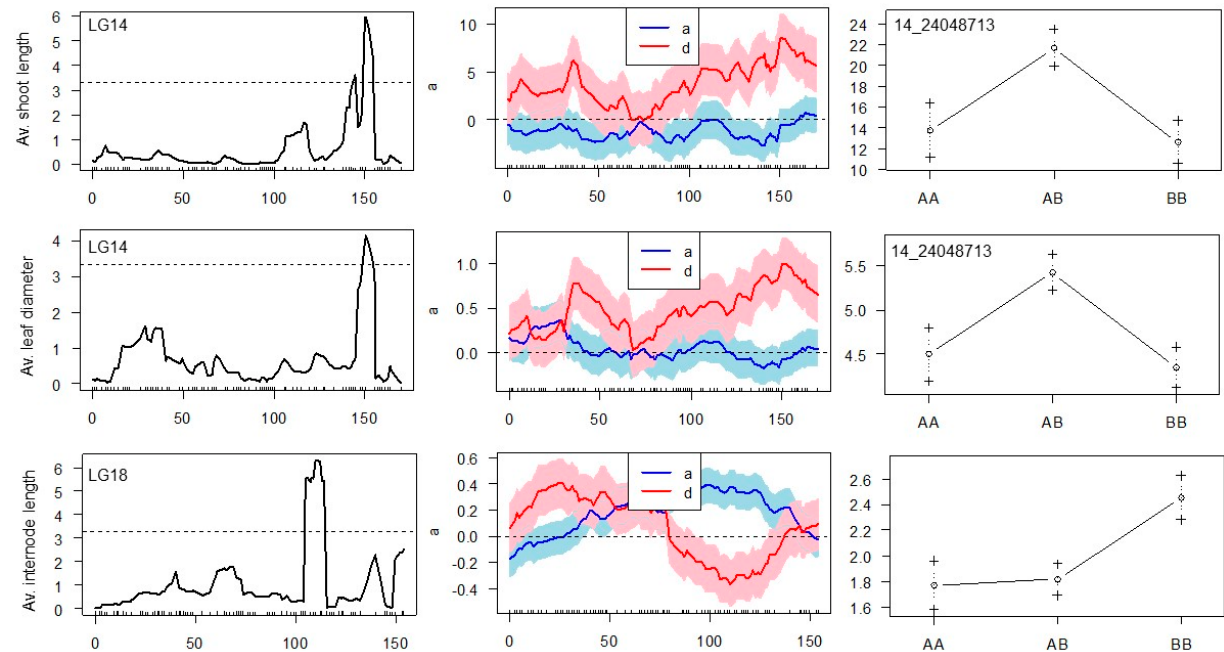
Figure 5. LOD profiles, additive, and dominance effect of the QTL Composite Interval Mapping for morphological traits assessed for ‘Dixie’ S1 progenies: top panel-average length of shoots per plant, middle panel-average leaf diameter, bottom panel-average internode length. Two colored lines in each of vertical middle plot represent the additive (a) and dominance (d) effects, colored regions indicate ± 1SE. Phenotype means (°) and error bars (+) are plotted at ±1 SE for each genotype group (AA, AB and BB). QTL peak mapped on LG14 coincided with the marker SNP_24048713 (150.55 cM), QTL peak on LG18 (116.8 cM) co-segregated with five SNP markers.